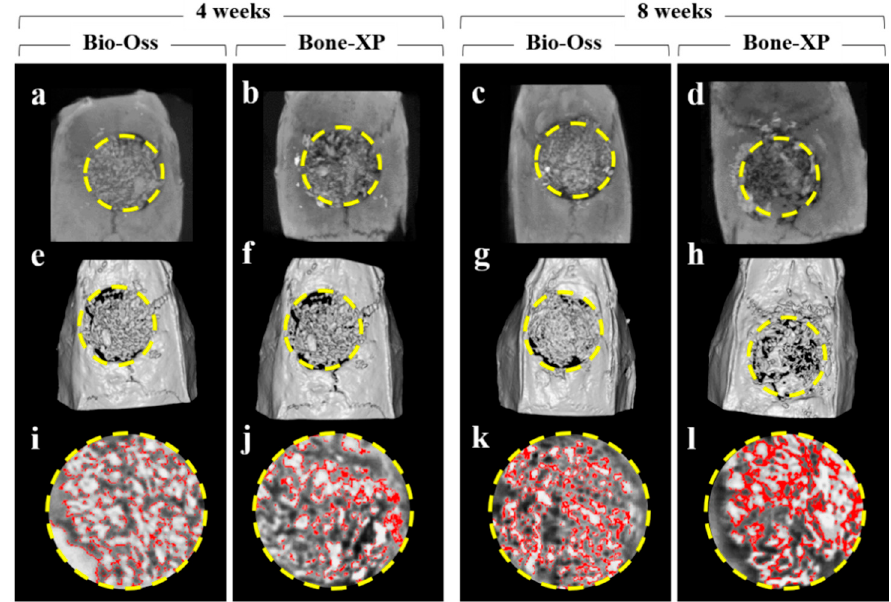
Figure 8. Micro-computed tomography ( μ CT) analysis images. ( a – d ) μ CT images. ( e – h ) 3D reconstructed μ CT images. ( i – l ) Classified new bone in area of interest (AOI). Yellow circle: AOI, Red colored area: newly formed bone.